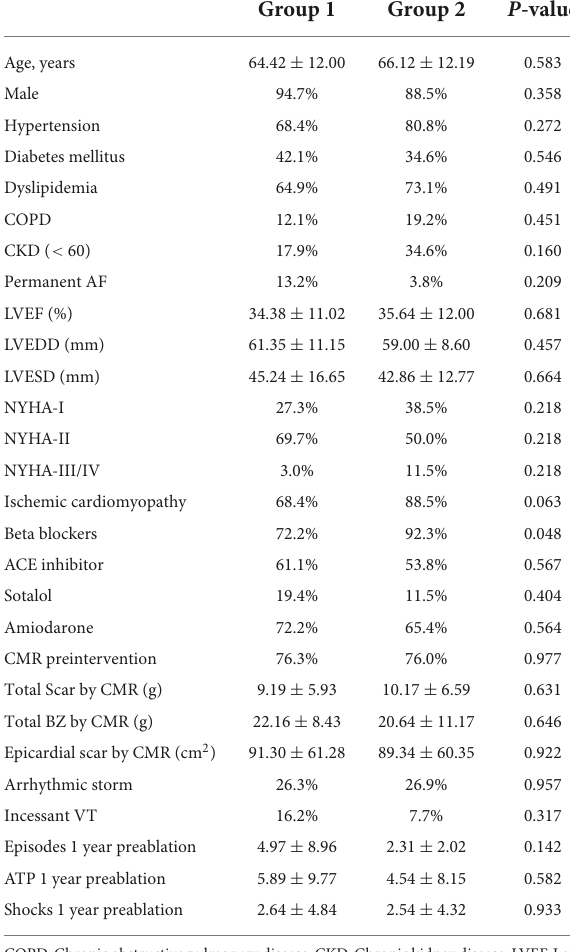
TABLE 1 Demographic and clinical baseline characteristics of the population.